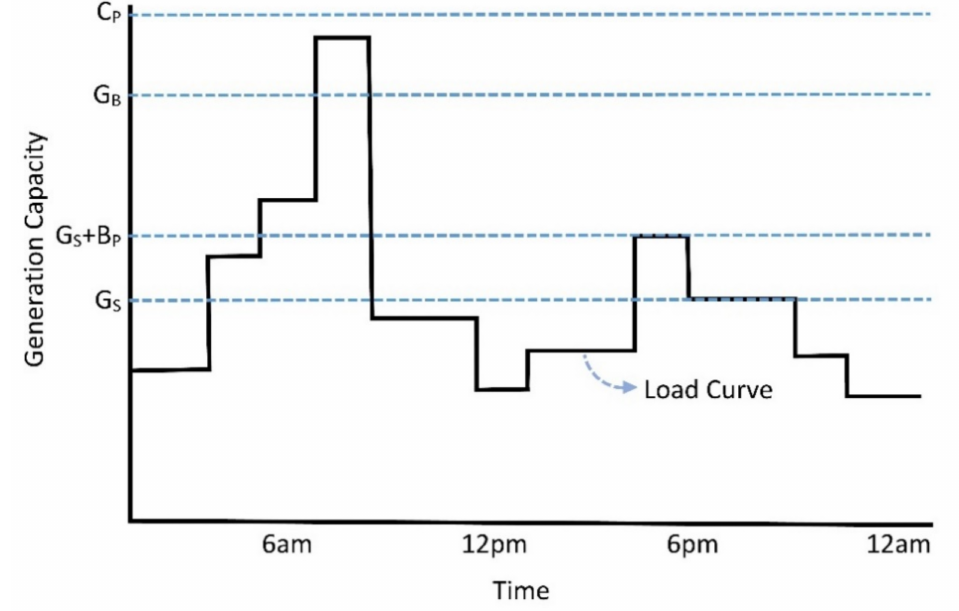
Figure 2. Various operational modes of the CVDTA algorithm. Table 2. Operating conditions of the various operational modes of the CVDTA